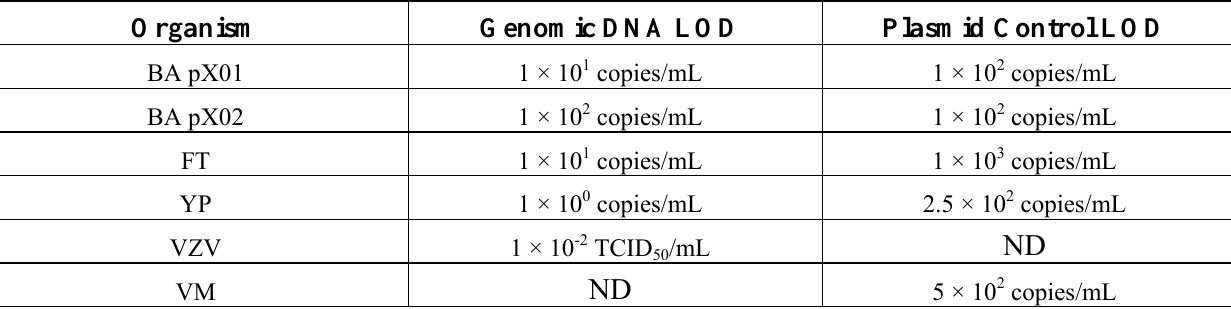
Table 1. Limits of detection for BioT DNA assay using genomic DNA and plasmid controls for each